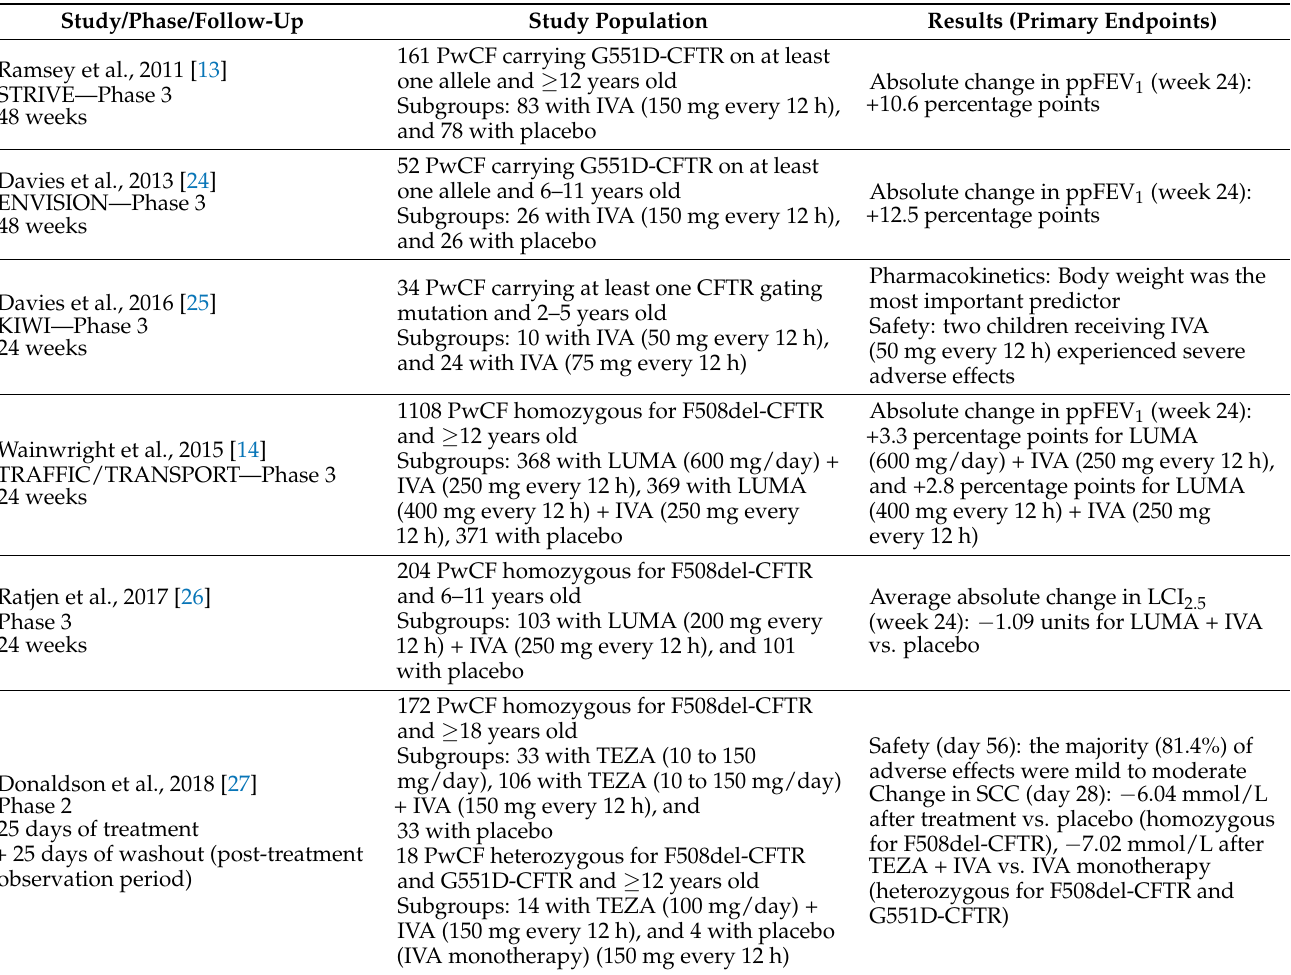
Table 1. Selected clinical trials assessing the safety and efficacy of IVA, LUMA-IVA, and TEZA-IVA in